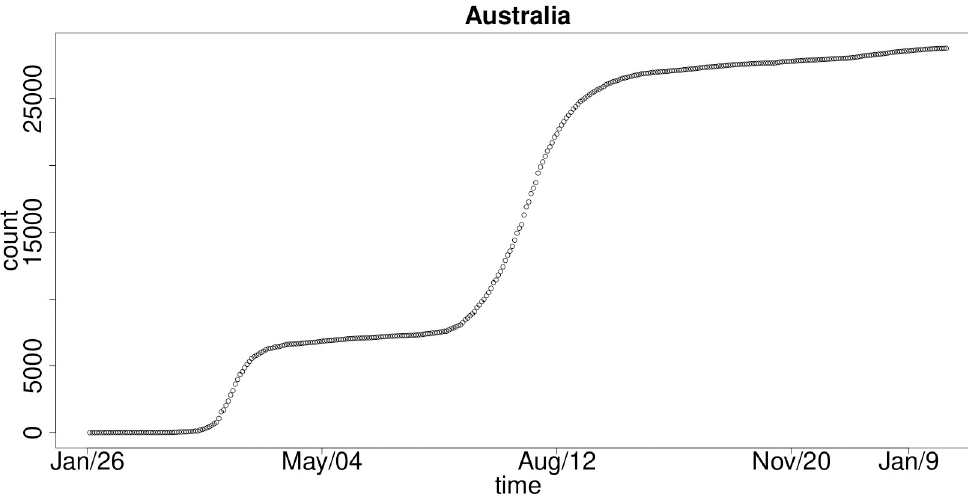
Fig 4. Cumulative COVID-19 national-level infections over time: Australia.